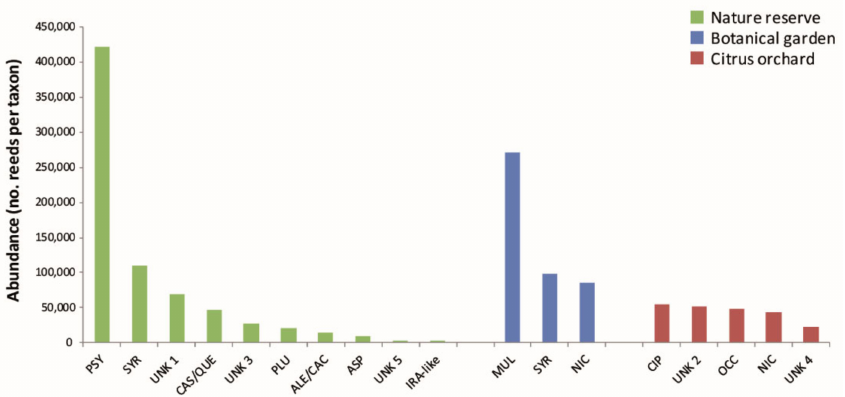
Figure 3. Read abundance of Phytophthora taxa identified in the three surveyed areas obtained by DNA metabarcoding. ALE/CAC = P. aleatoria / P. cactorum ; ASP = P. asparagi ; CAS/QUE = P. castane- torum / P. quercina ; CIP = P. citrophthora ; IRA = P. iranica -like; MUL = P. multivora ; NIC = P. nicotianae ; OCC = P. occultans ; PLU = P. plurivora ; PSY = P. psychrophila ; SYR = P. syringae ; UNK 1 = Phytoph- thora unknown sp. 1 ; UNK 2 = Phytophthora unknown sp. 2; UNK 3 = Phytophthora unknown sp. 3; UNK 4 = Phytophthora unknown sp. 4; UNK 5 = Phytophthora unknown sp.